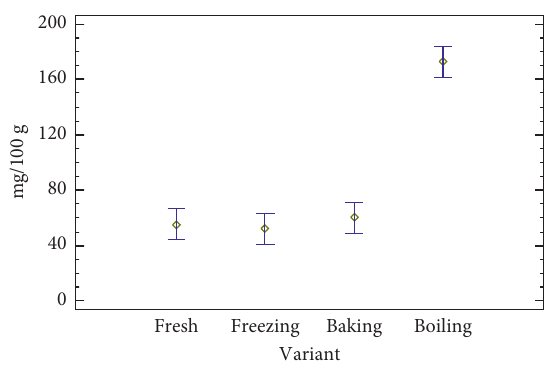
Figure 4: Total carotenoids content of fresh and after boiling, baking, and freezing treatments, on the pulp of Cucurbita moschata Duch. varieties in dry matter ( p <